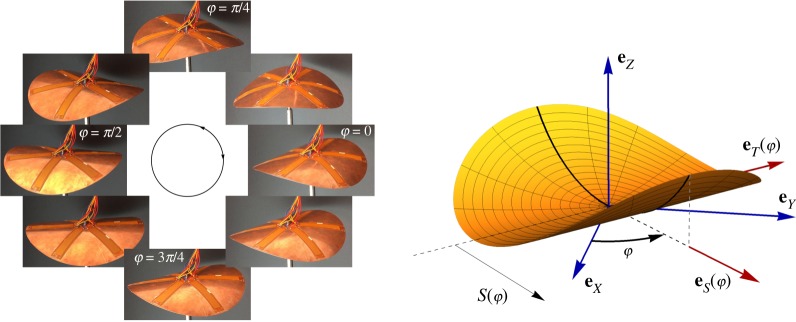
Shape-wave in the piezoelectric actuated neutrally stable shell. Left: experiments from [18]. Right: Kinematics and notation for the cylindrical shell used in this paper, where φ gives the rotation of the curvature axis.